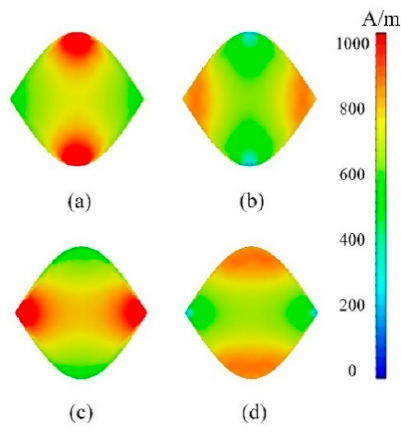
Figure 3. Distributions of surface current intensity of the TMA. ( a ) 0.5 THz, TE; ( b ) 1 THz, TE; ( c ) 0.5 THz, TM; ( d ) 1 THz, TM.